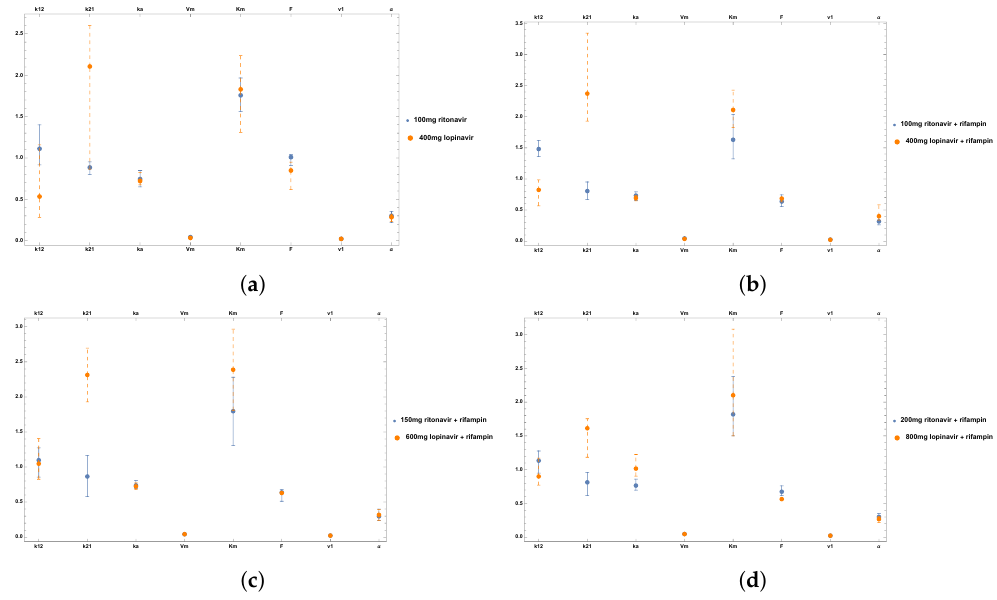
Figure 7. Lopinavir standard dose regimen and Day 4 dose regimen. ( a ) 400 mg lopinavir. ( b ) 400 mg lopinavir + 600 mg rifampin. ( c ) 600 mg lopinavir + 600 mg rifampin. ( d ) 800 mg lopinavir + 600 mg rifampin.